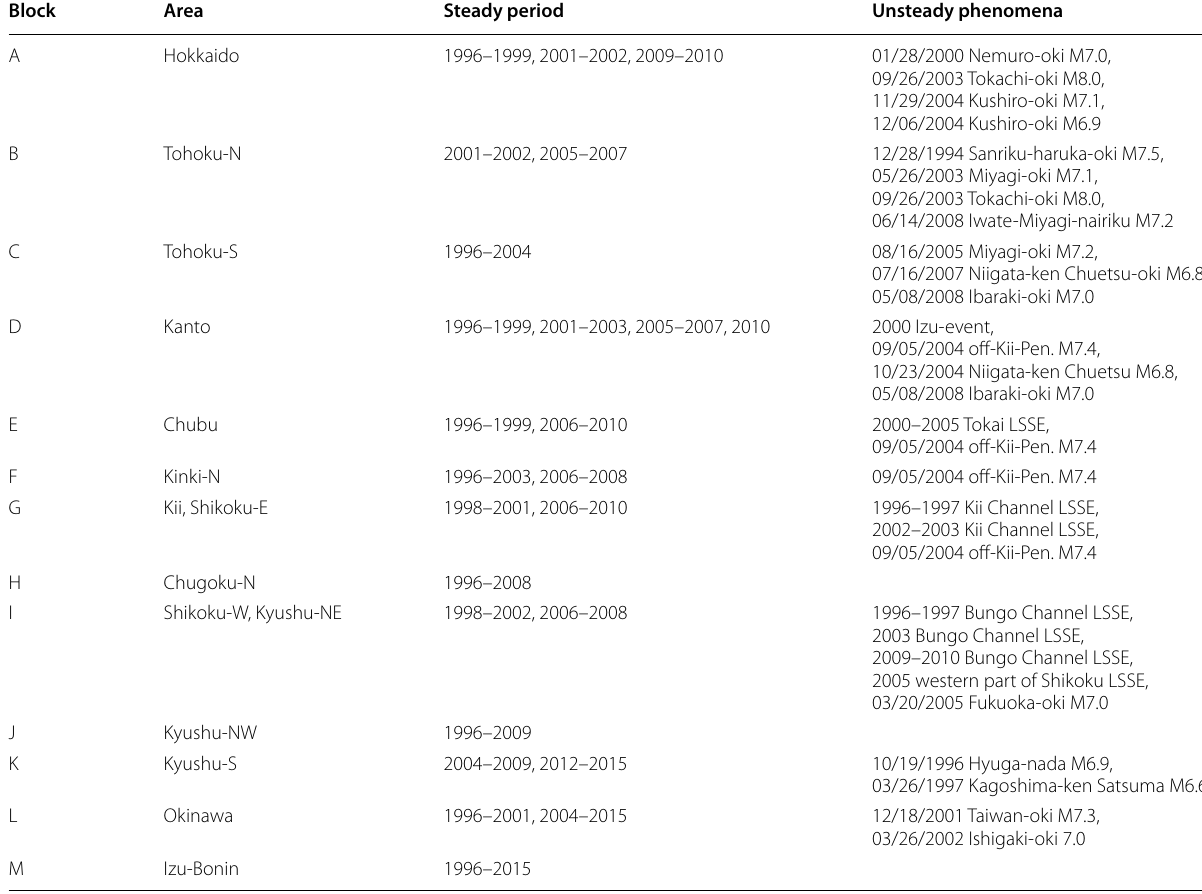
Table 1 Description of blocks (see Fig. 1) for estimating steady-state GNSS station velocities